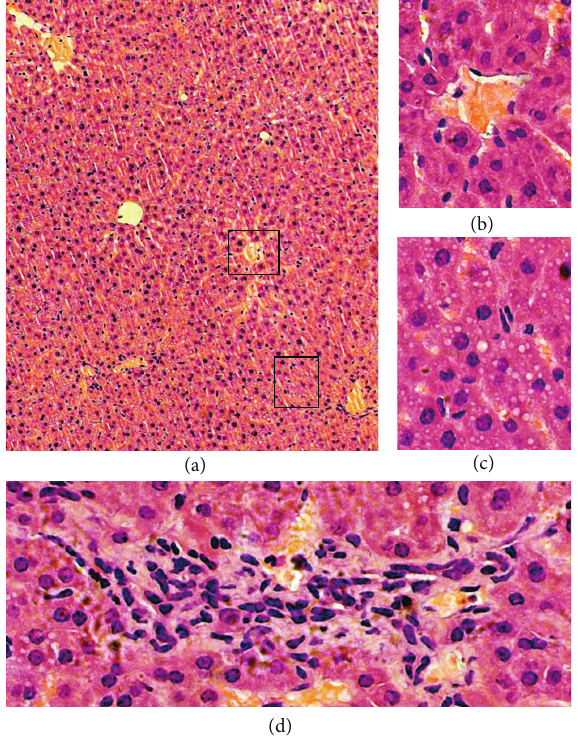
Figure 4: Anti-PD-L1 antibody reverses morphology of liver injury induced by sepsis. Mice were administered anti-PD-L1 antibody (50 𝜇 g, i.p.). Liver specimens were sampled 24 hours after surgery. The liver tissue sections were stained with H and E. Black squares in (a) were magnified into (b), (c), and (d). Original magnification was × 200 for (a); × 400 for (b), (c), and